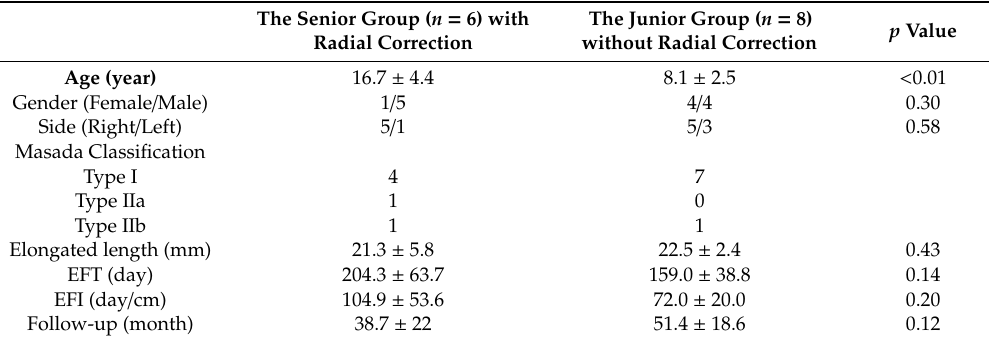
Table 1. Demographic characteristics of patients.